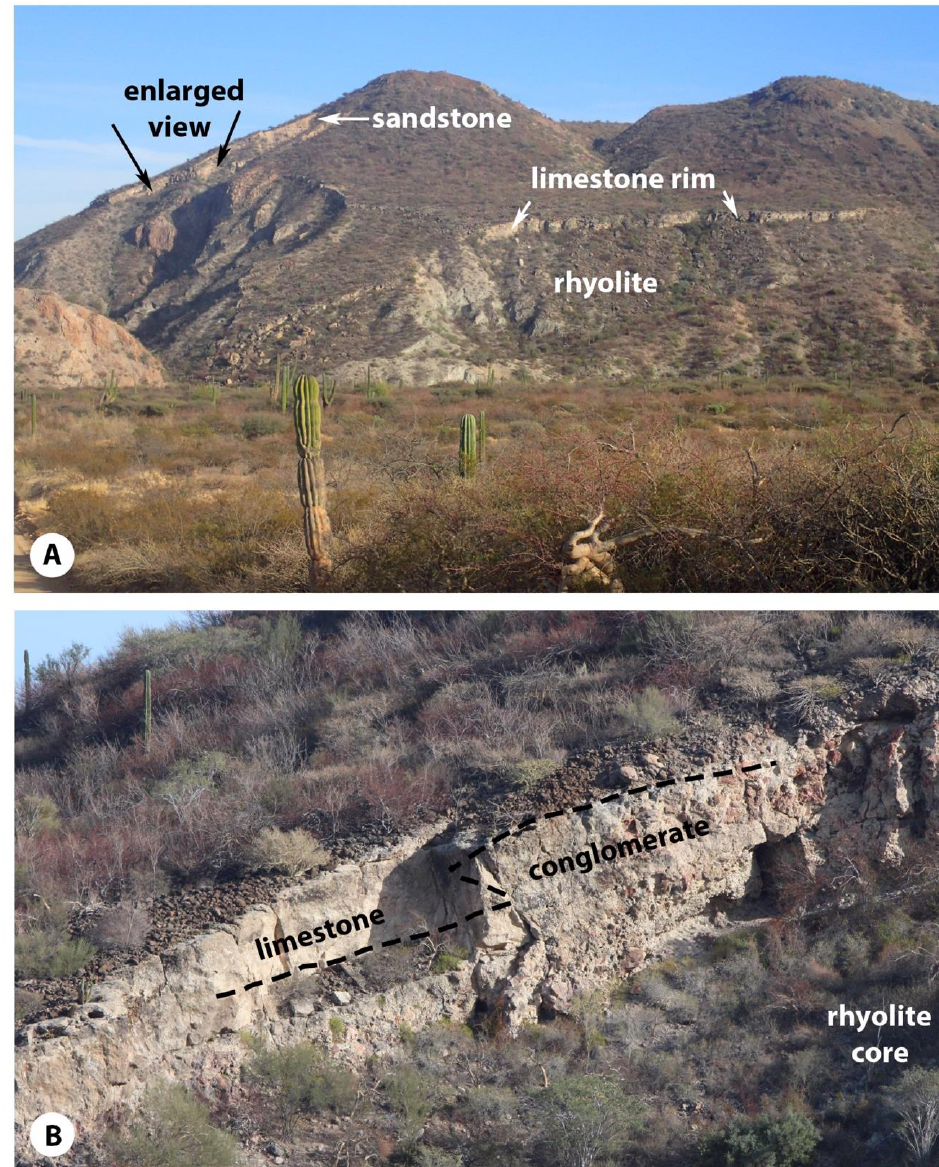
Figure 10. Rhyolite dome from the central part of the San Basilio basin: ( A ) View to the southwest toward the dome with the eroded rhyolite slope and overlying limestone rim marked, in addition to an exposure of sandstone (white arrows) in the middle part of the structure. Note area of enlargement (black arrows) shown below. ( B ) Enlargement (from above), showing the relationship between limestone and rhyolitic conglomerate eroded from the core of the dome.